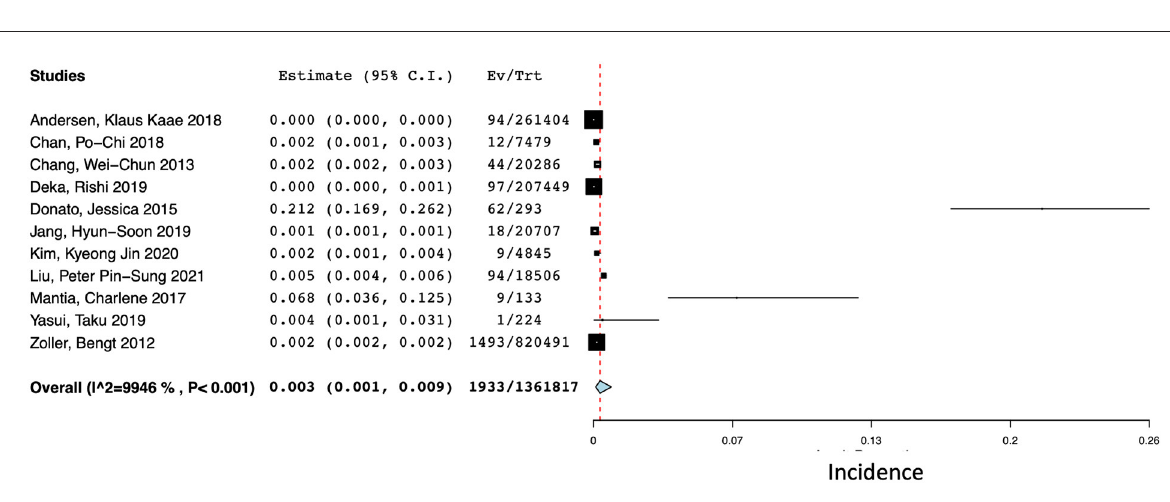
FIGURE4 Forest plot of the pooled incidence of spontaneous ICH at 1 year after a diagnosis of